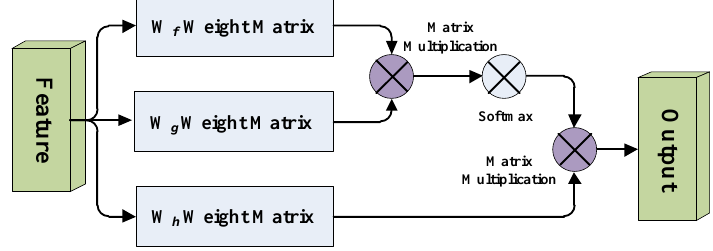
Figure 2. Diagram of the self-attention mechanism.